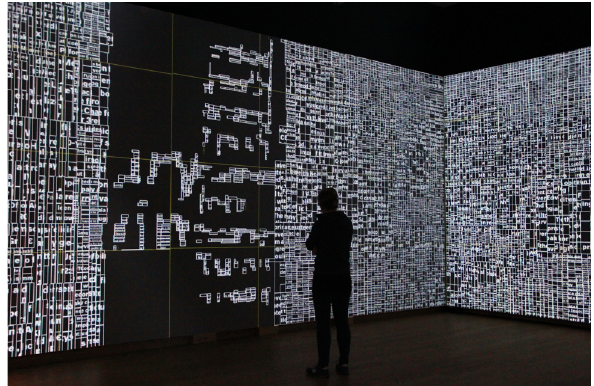
Figure 14 | Type/Dynamics, LUST,